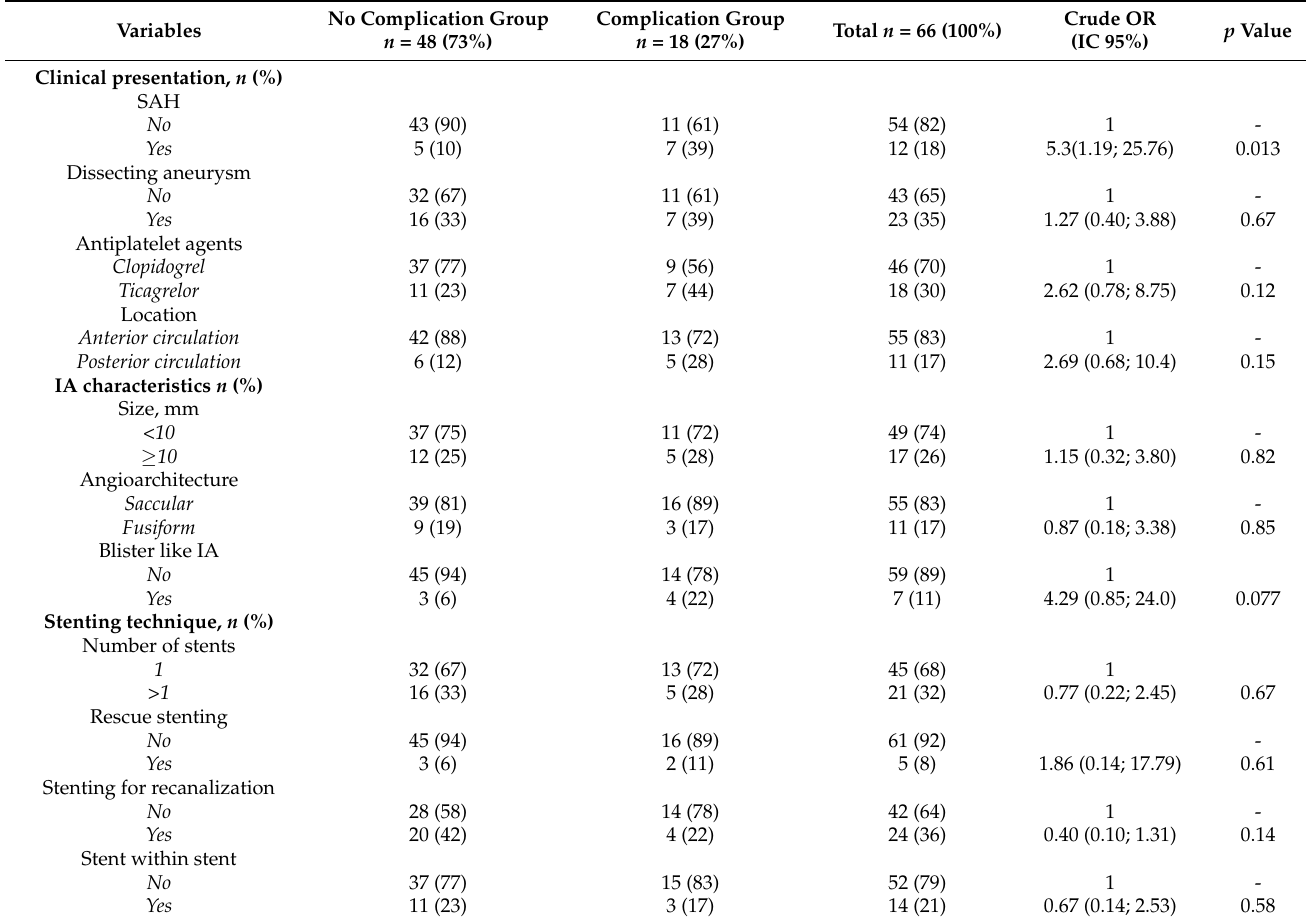
Table 3. Univariate analysis to identify factor associated with major intracranial complication immediately after or within 30 days after